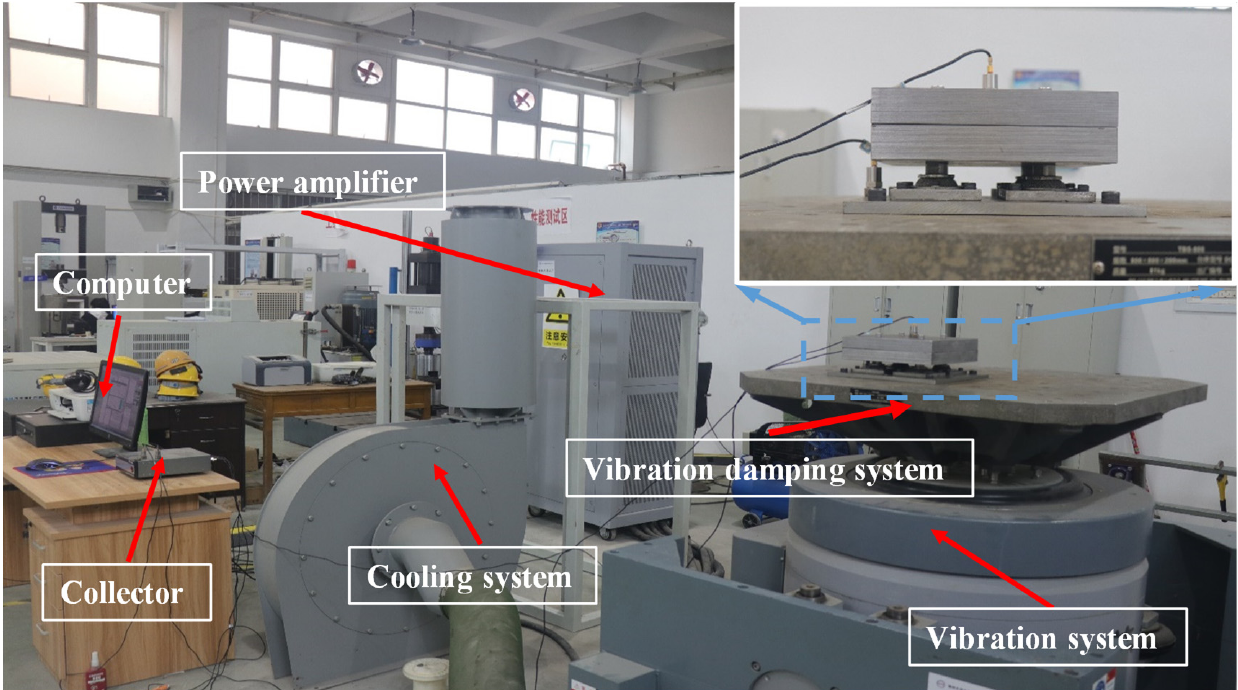
Figure 9. Vibration test system.